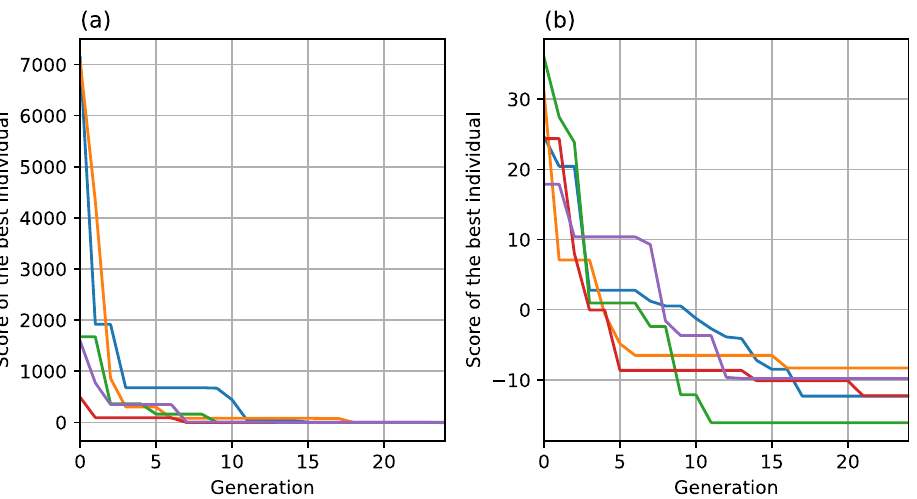
Figure 9. Score of the best individual in function of generation number during gains selection using genetic algorithms for: ( a ) fitness function based on linearized equations, ( b ) universal fitness function proposed in this study.